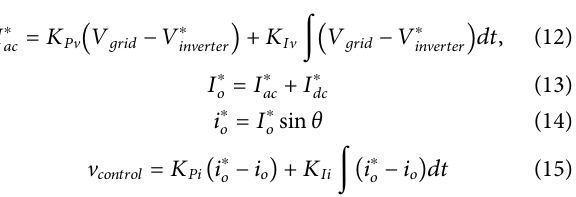
Figure 5 is a schematic diagram of the single-phase inverter system vector projection on a stationary reference frame, so the system ’ s active power and reactive power can be obtained from Eq. 22 and Eq. 23 , respectively. The active output power of the single-phase inverter can be expressed as